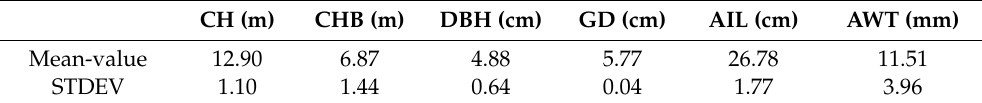
Figure 2. The culm morphological characteristics of the T. oliveri . ( a ) Appearance of culms below branches; ( b ) the cross section of the culm. Table 1. Basic morphological parameters of culm of the T. oliveri. Table 1. Basic morphological parameters of culm of the T. oliveri .